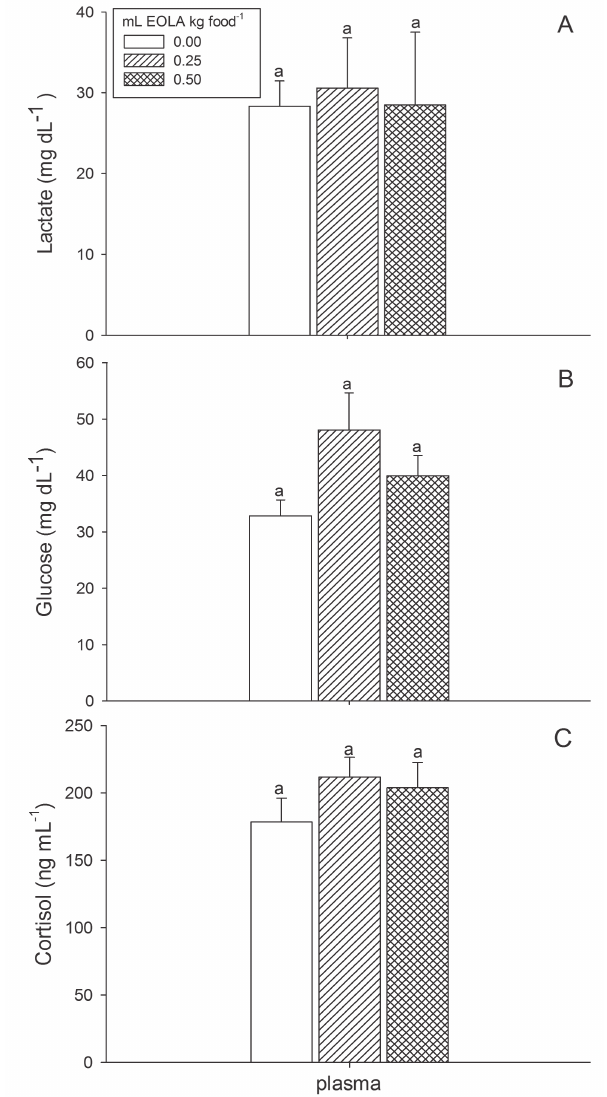
Fig. 2. Plasma and hepatic activities of aspartate aminotransferase (AST) (A) and alanine aminotransferase (ALT) (B) of Rhamdia quelen fed with different concentrations of dietary essential oil of Lippia alba (EOLA). Mean ± SEM. Different letters indicate significant differences (P < 0.05) between